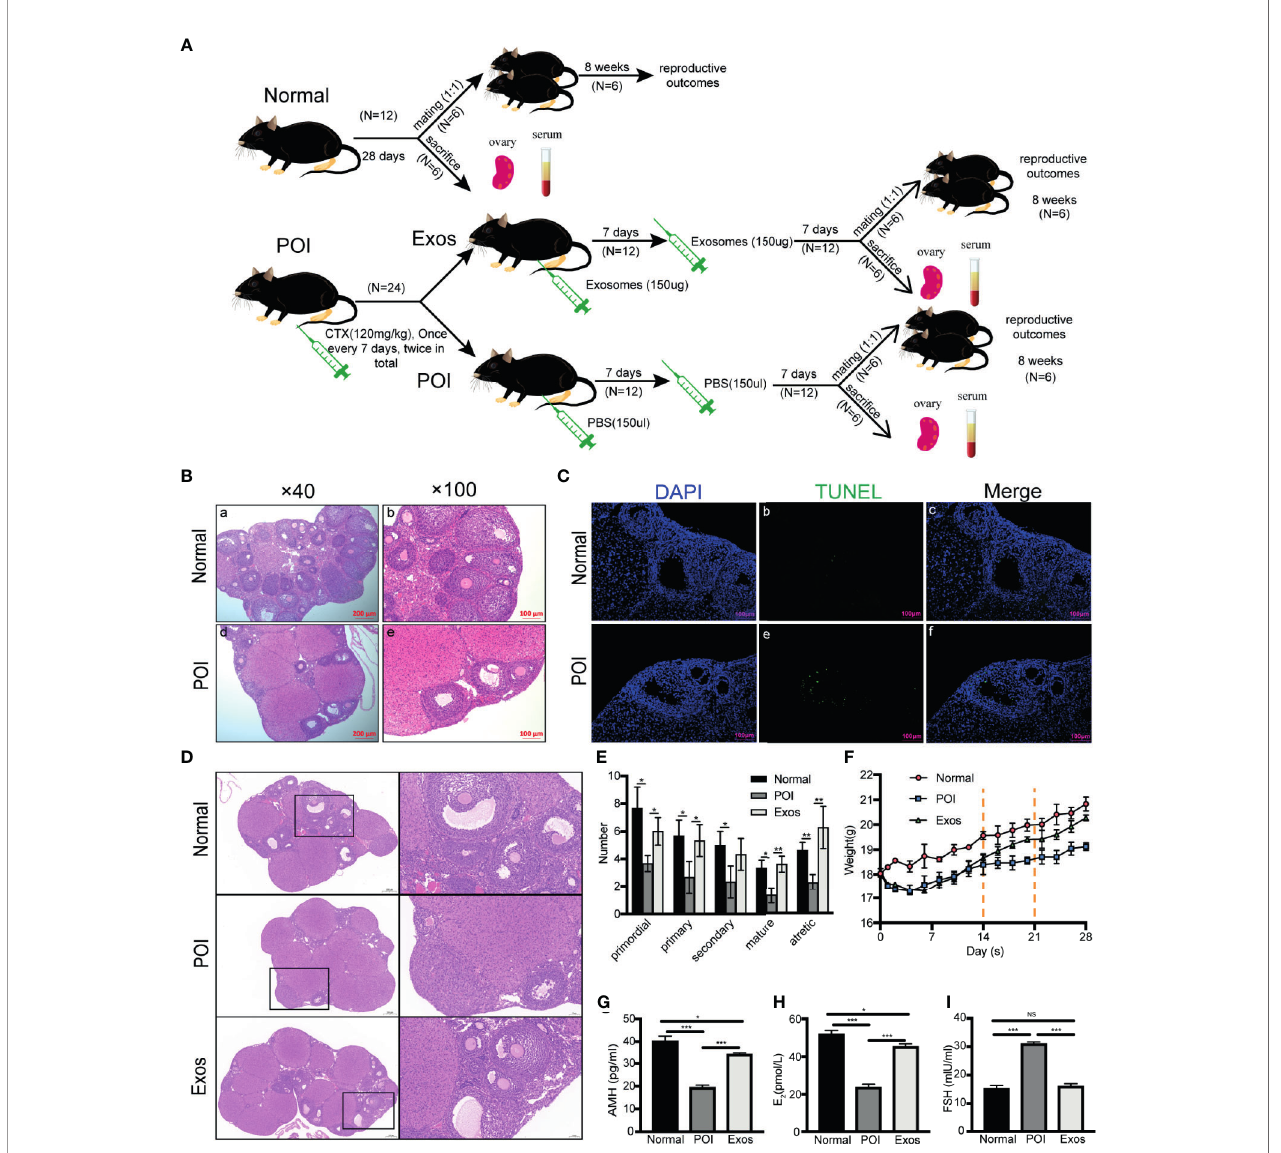
FIGURE 3 | Therapeutic effects of hUCMSC-Exos in POI mice models. (A) Experimental timeline. After POI models were established by the injection of CTX twice, hUCMSC-Exos transplantation was performed. Seven days after the last treatment, six mice were sacri fi ced while six other mice were mated with male mice (1:1). (B) H&E staining of ovaries in the Normal and POI group. Scale bar: 100 m m and 200 m m. (C) Apoptosis was measured by TUNEL staining in the Normal and POI group. Cell nuclei were stained by DAPI (blue fl uorescence) while apoptotic cells were stained with FITC (green fl uorescence). Scale bar: 100 m m. (D) HE staining of ovaries in three different groups. Scale bar: 50 m m and 200 m m. (E) The number of follicles in different stages in each group. (F) Mice weight changes in the three groups. The dotted line indicates mice received treatment for 14 days and 21 days. (G) AMH, (H) E 2, and (I) FSH levels were signi fi cantly elevated in the Exo group compared to the POI group and were near normal levels. Data are presented as the mean ± SD. * p < 0.05, ** p < 0.01, *** p < 0.001, ns, no signi fi cance. Data are representative of three independent experiments in each